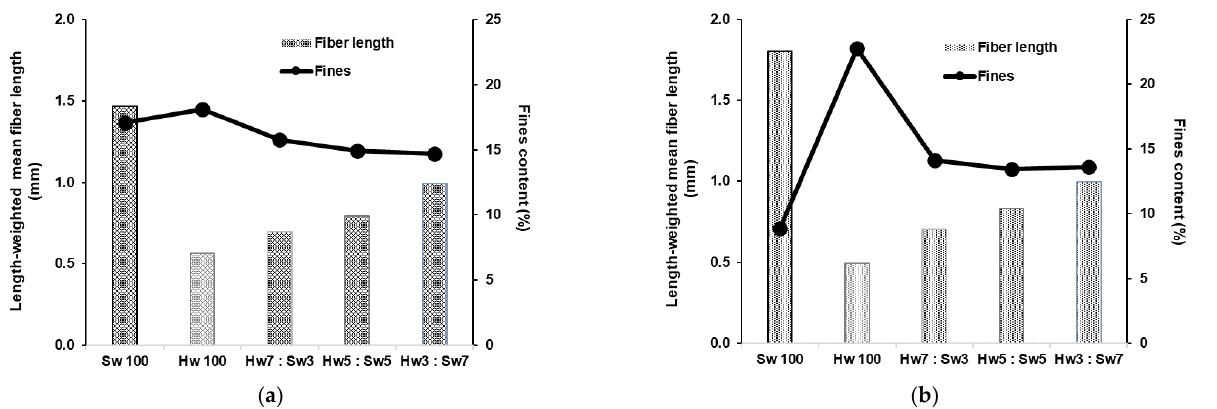
Figure 8. Effect of CEL on mean fiber length and fines content of the mixed pulps: ( a ) PA55; ( b ) PB97.